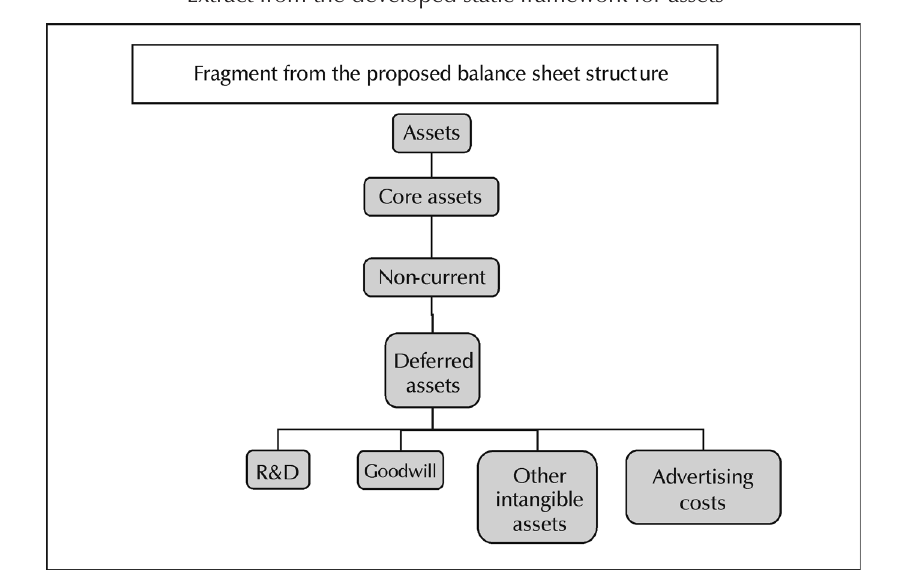
Extract from the developed static framework for